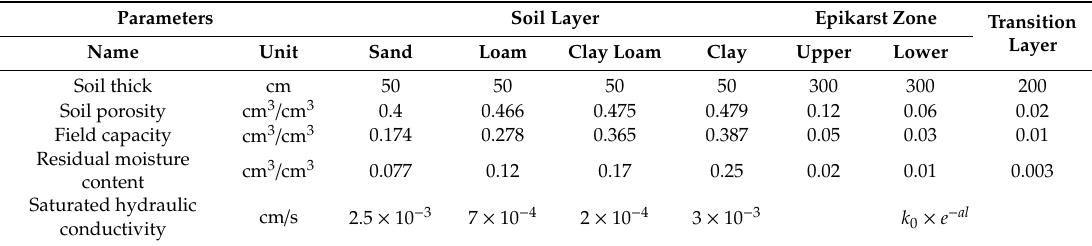
Table 2. Equivalent soil moisture movement parameters in karst